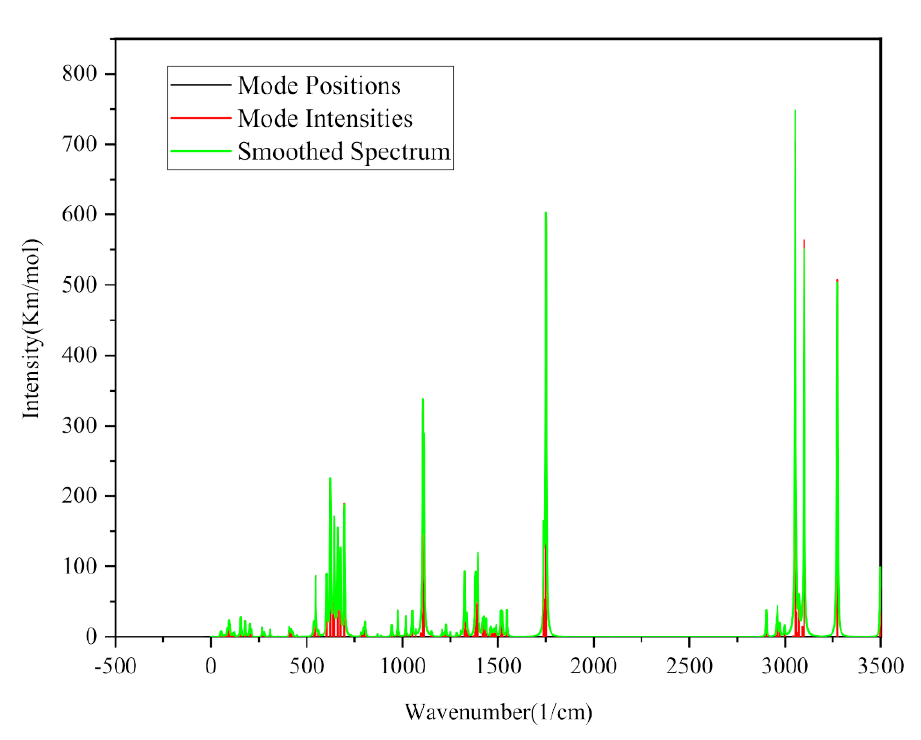
Figure 2. Phonon spectrum of ChCl-2MA deep eutectic solvent.